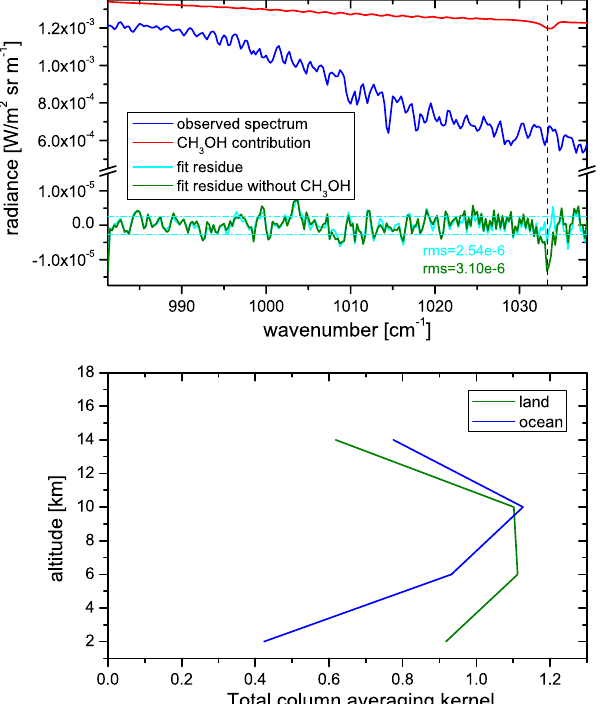
Fig. 3. Top panel: Example of a methanol retrieval from an IASI spectrum recorded over Namibia (20 . 16 ◦ S–21 . 50 ◦ E) on 20 Octo- ber 2008. The observed (blue curve) spectrum is shown together with the fit residue (in cyan) and the dashed horizontal lines de- limit this residue by its RMS value. The dark green curve is the fit residue when CH 3 OH is not taken into account in the retrieval, the red curve represents the calculated CH 3 OH contribution to the spec- trum and the dashed vertical line indicates the detectable CH 3 OH absorption band. Bottom panel: Mean total column averaging ker- nels presented for retrievals performed over land (green curve) and over ocean (blue curve).